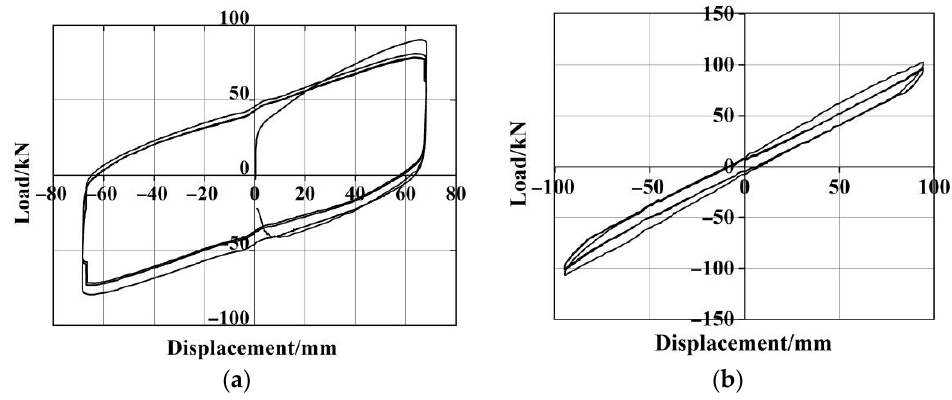
Figure 8. The hysteretic curve of isolation bearing: ( a ) LRB400; ( b ) LNR500.